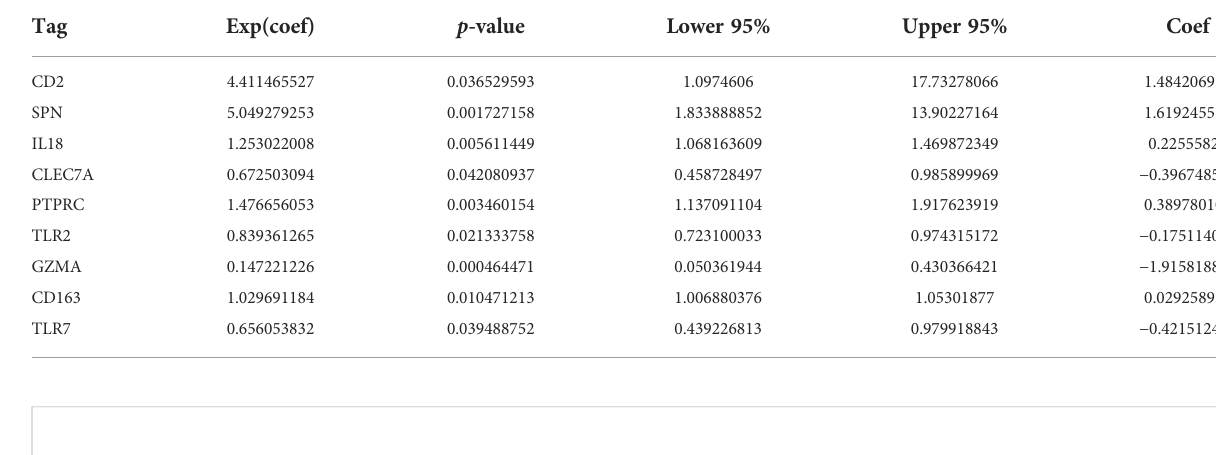
TABLE 3 Multivariate Cox regression analysis.